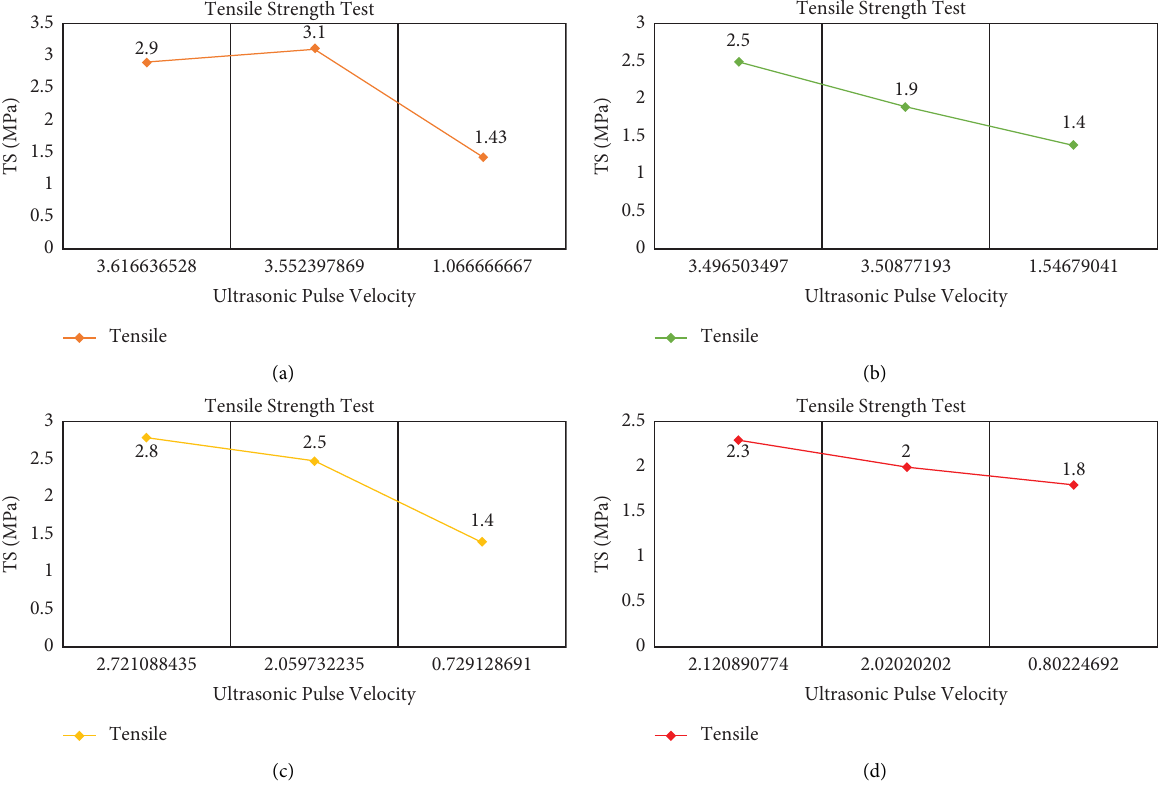
Figure 19: (a–d) Relationship between ultrasonic pulse velocity and tensile strength test of the concrete